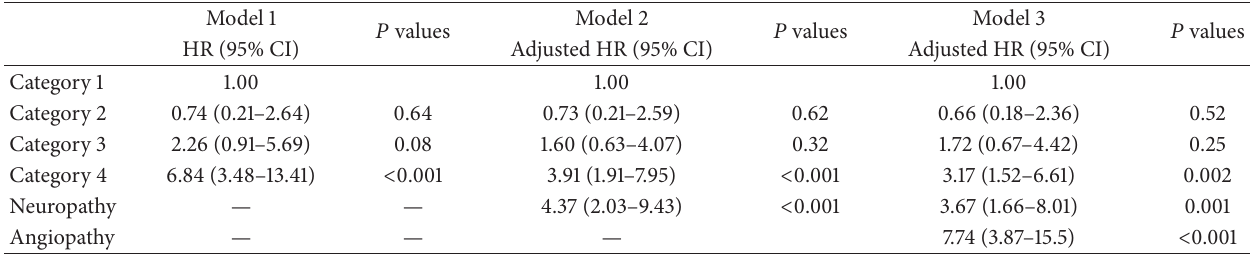
Table 3: Hazard ratios for diabetic foot ulcer in the adjusted models according to the microangiopathy complications category at baseline. Model 1 𝑃